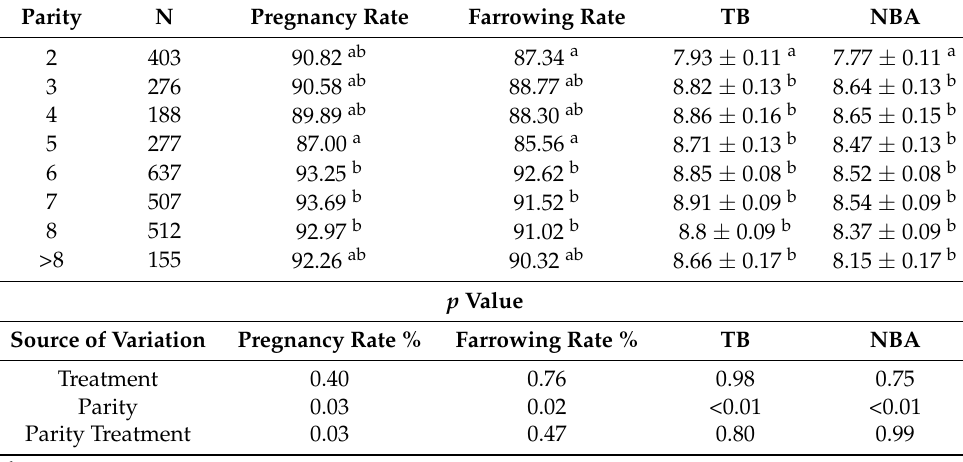
Table 2. Reproductive outcome of Iberian sows according to parity.